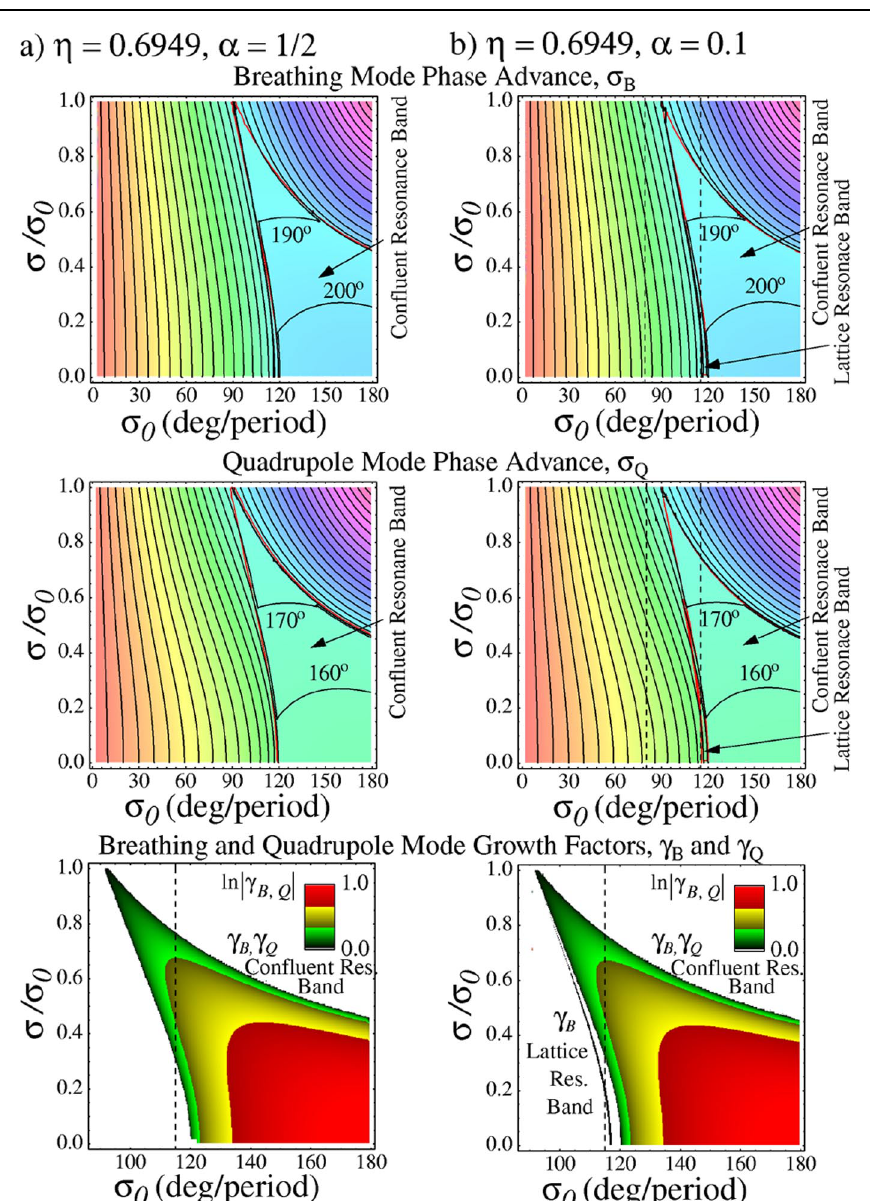
FIG. 16. (Color) Contours of (upper row) breathing and (middle row) quadrupole mode phase advances ( (cid:24) , (cid:24) ) and (bottom row) B Q , (cid:6) ) as a function of (cid:24) and (cid:24)=(cid:24) for a quadrupole focusing channel with occupancy (cid:31) (cid:1) 0 : 6949 . Results are growth factors ( (cid:6) B Q 0 0 shown for syncopation factors # (cid:1) 1 = 2 (FODO) and # (cid:1) 0 : 1 in (a) and (b). In the upper and middle rows, black contour lines (cid:1) 10 (cid:31) , 20 (cid:31) , 30 (cid:31) ; . . . , for ‘ (cid:1) B; Q , colors vary continuously with changes in (cid:24) , and thresholds of instability correspond to (cid:24) ‘ ‘ (cid:4) with (cid:6) > 1 are labeled with continuously varying colors as bands are marked with red lines. In the bottom row, values of ln (cid:3) (cid:6) ‘ ‘ indicated in the key. Identical color schemes are used in (a) and (b) to measure mode phase advances and growth factors. Vertical dashed lines in the plots of # (cid:1) 0 : 1 correspond to cross-section plots in Fig.